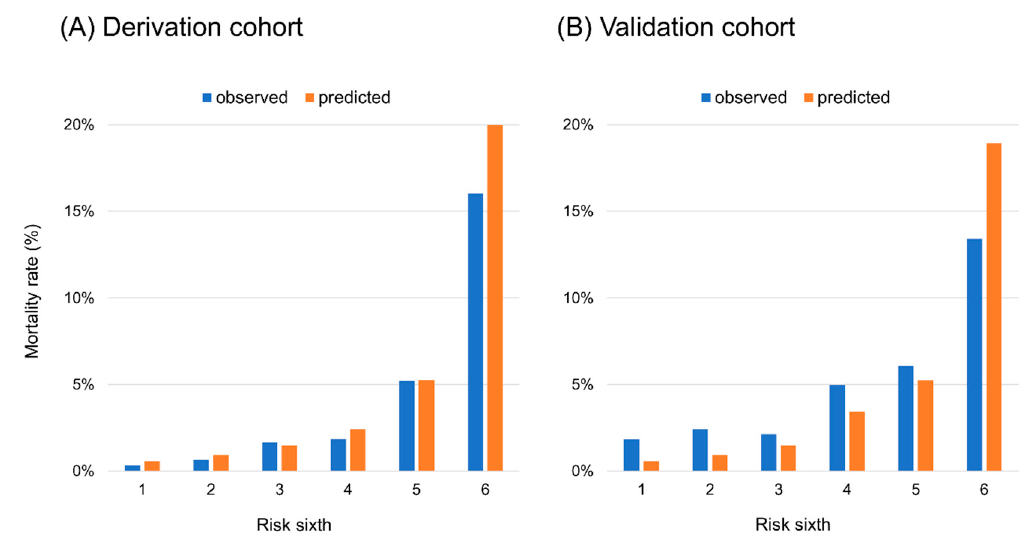
Figure 2. Calibration plots of the integer score applied to the ( A ) derivation cohort and ( B ) validation cohort.